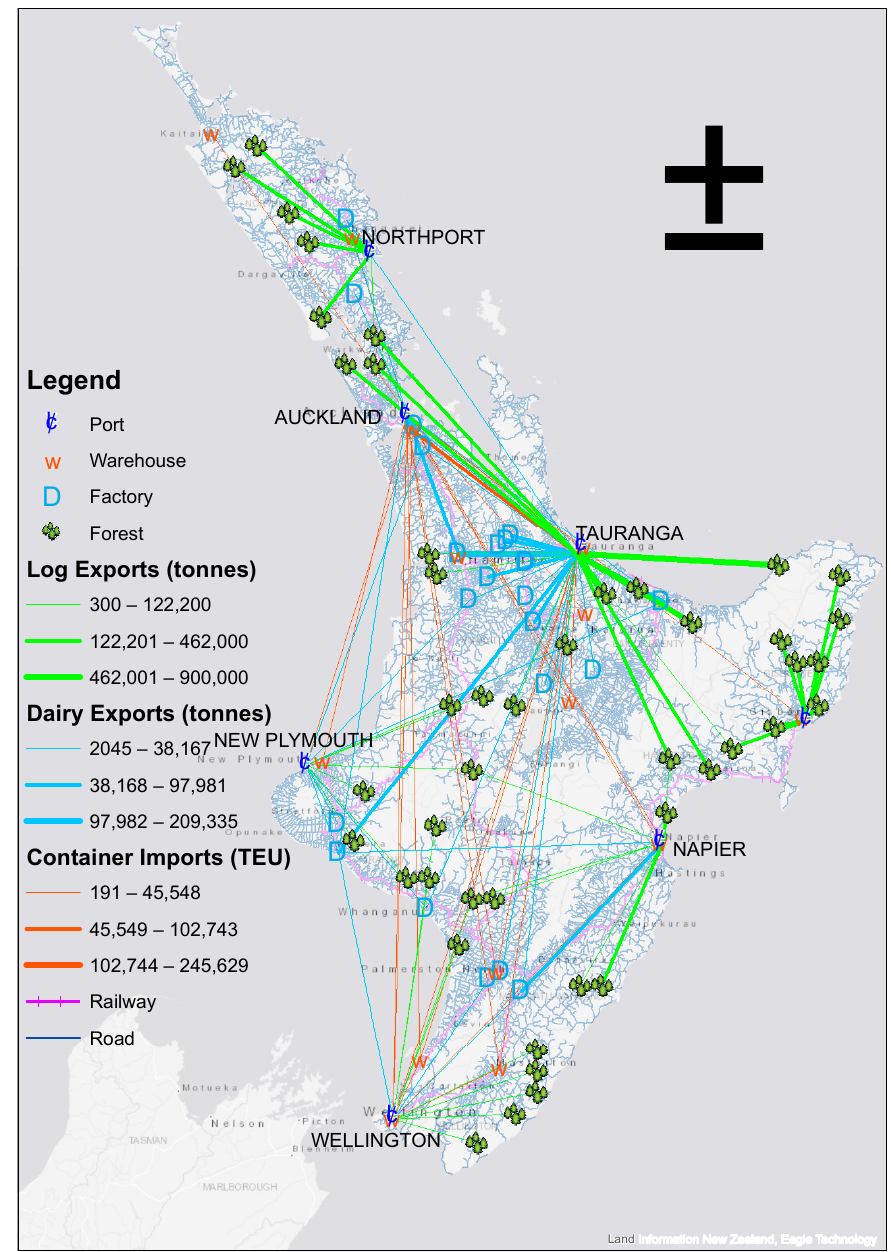
Figure 4. Data sources and freight distribution.